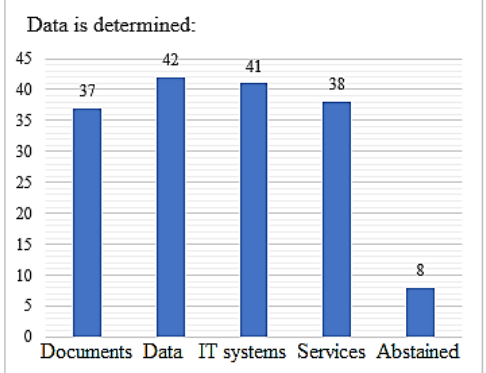
Fig. 3. Determining how and which data are used in the process.